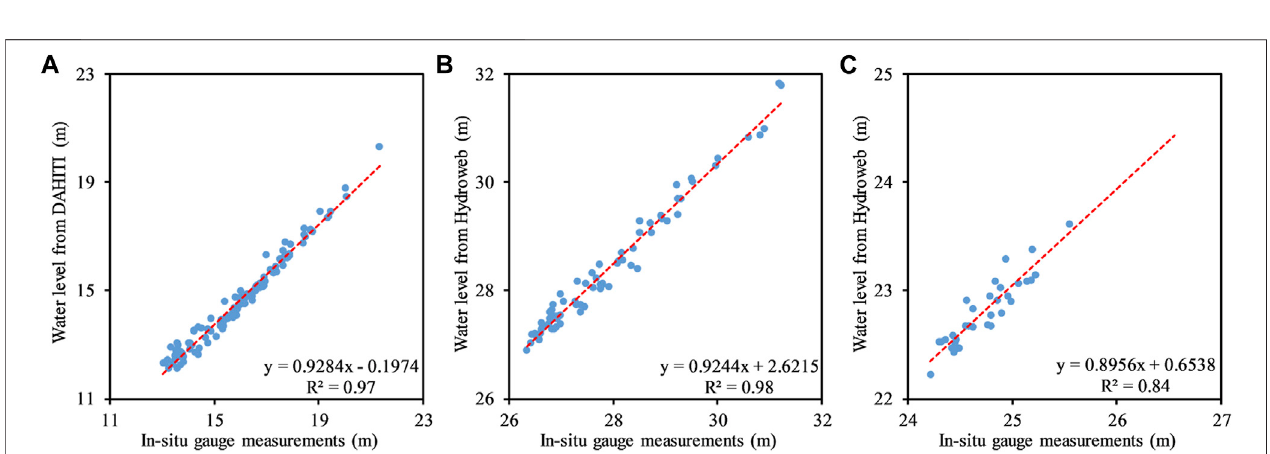
FIGURE 2 | Scatter plots of water level obtained from Hydroweb or DAHITI against in-situ gauge measurements. (A) Poyang Lake; (B) Dongting Lake; and (C) Hong Lake.